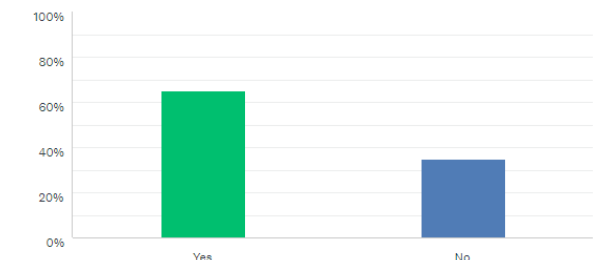
Figure 3. Respondents view of Counselling as an